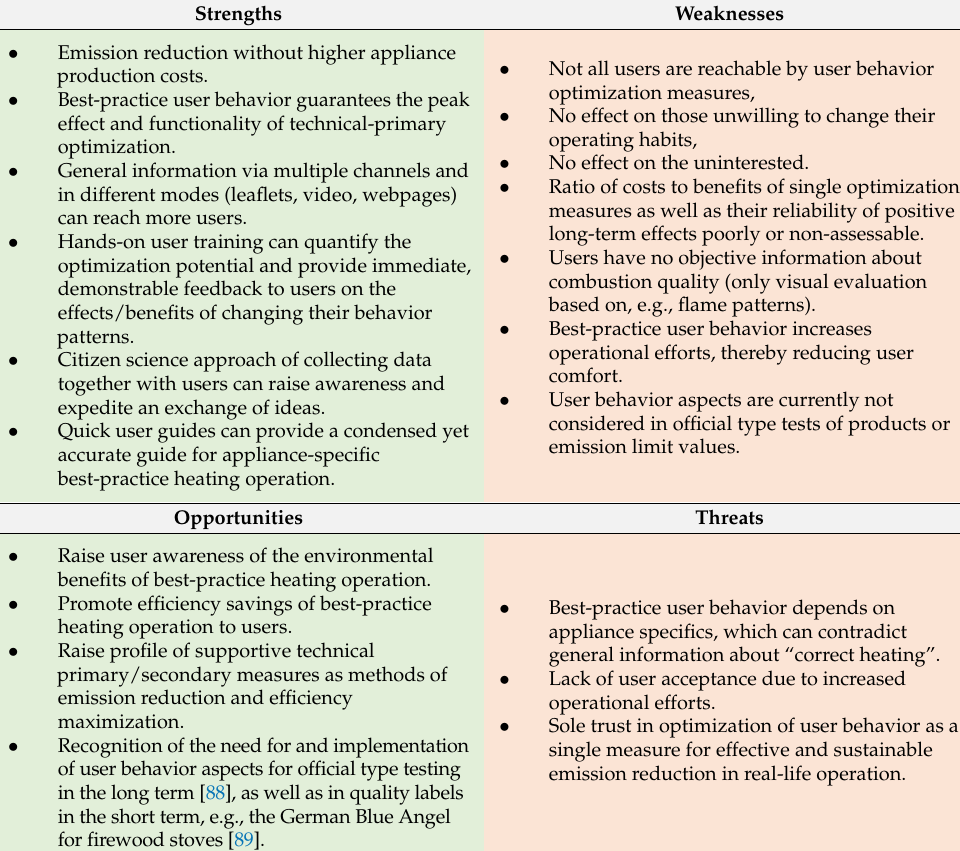
Table 6. SWOT analysis of non-technical primary measures: general information about “correct heating”, hands-on user training, quick user